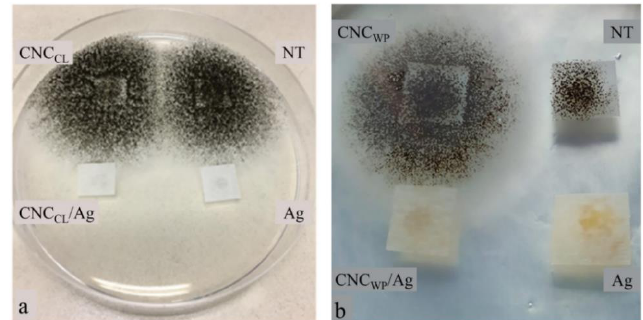
Figure 10. Growth inhibition of Aspergillus niger on Whatman paper samples, not treated (NT) and treated with CNCs obtained from different sources (CNC CL from cotton linter and CNC WP from waste paper), CNCs/Ag and Ag nanoparticles. ( a ) CNC CL ( b ) CNC WP . Reproduced with permission [16]. Copyright © 2019,